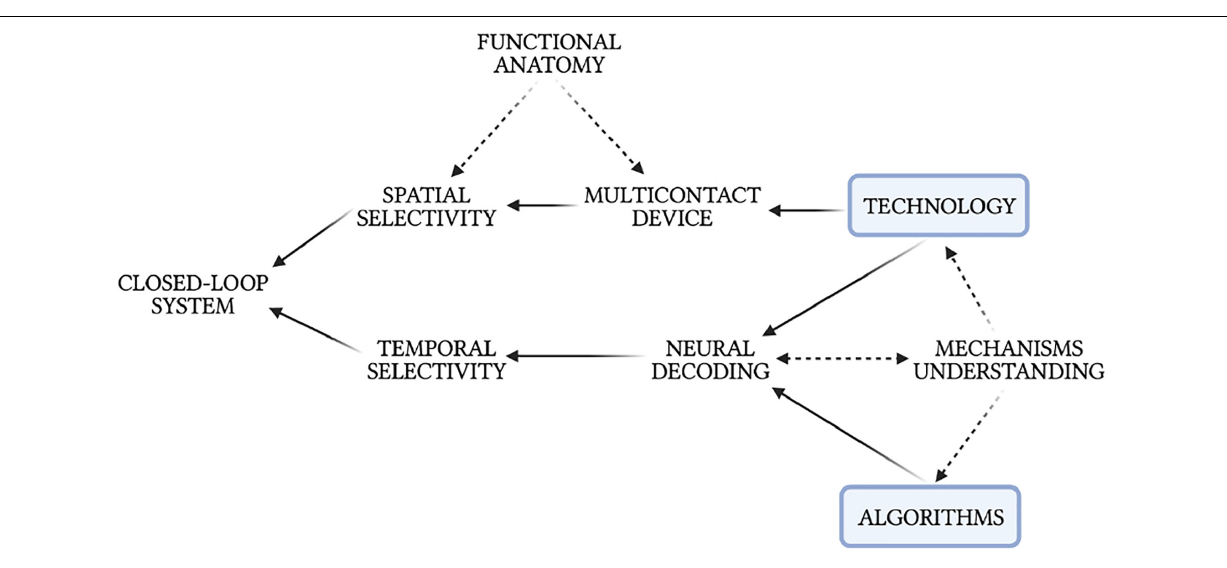
Frontiers in Cardiovascular Medicine |